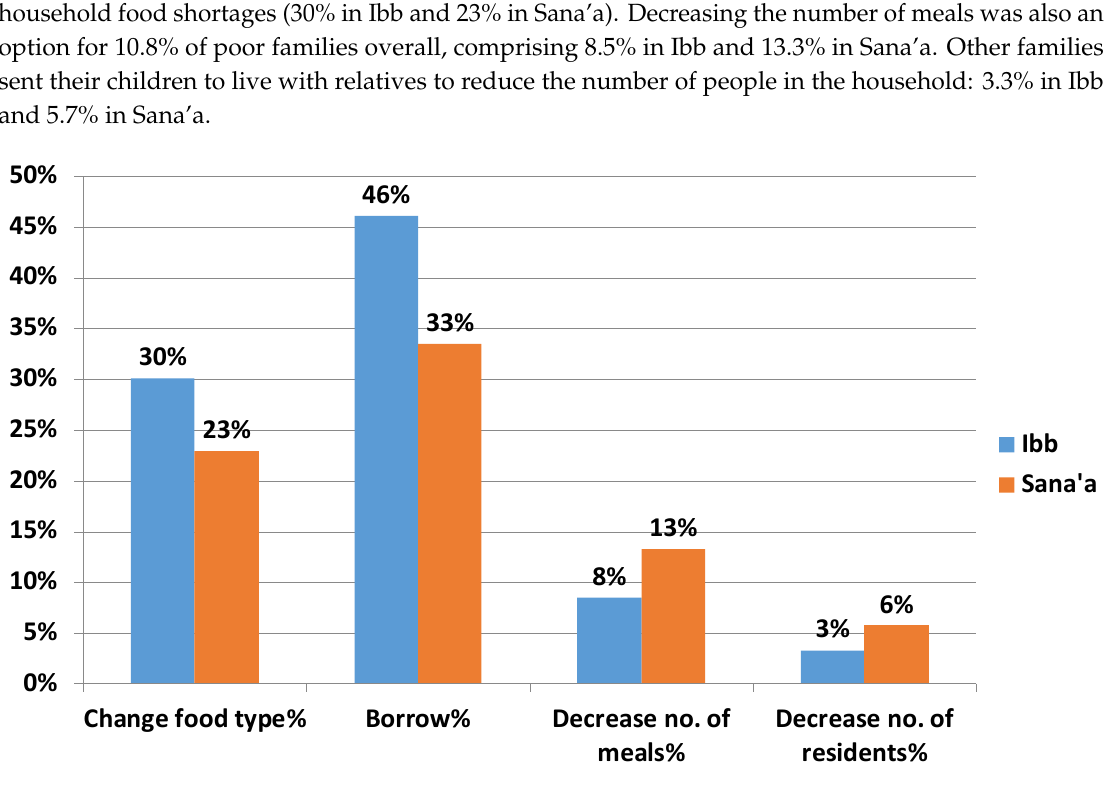
Figure 1. Distribution of coping mechanisms for food insecurity among families in the target communities of Ibb and Sana’a by governorate (multiple answers possible).